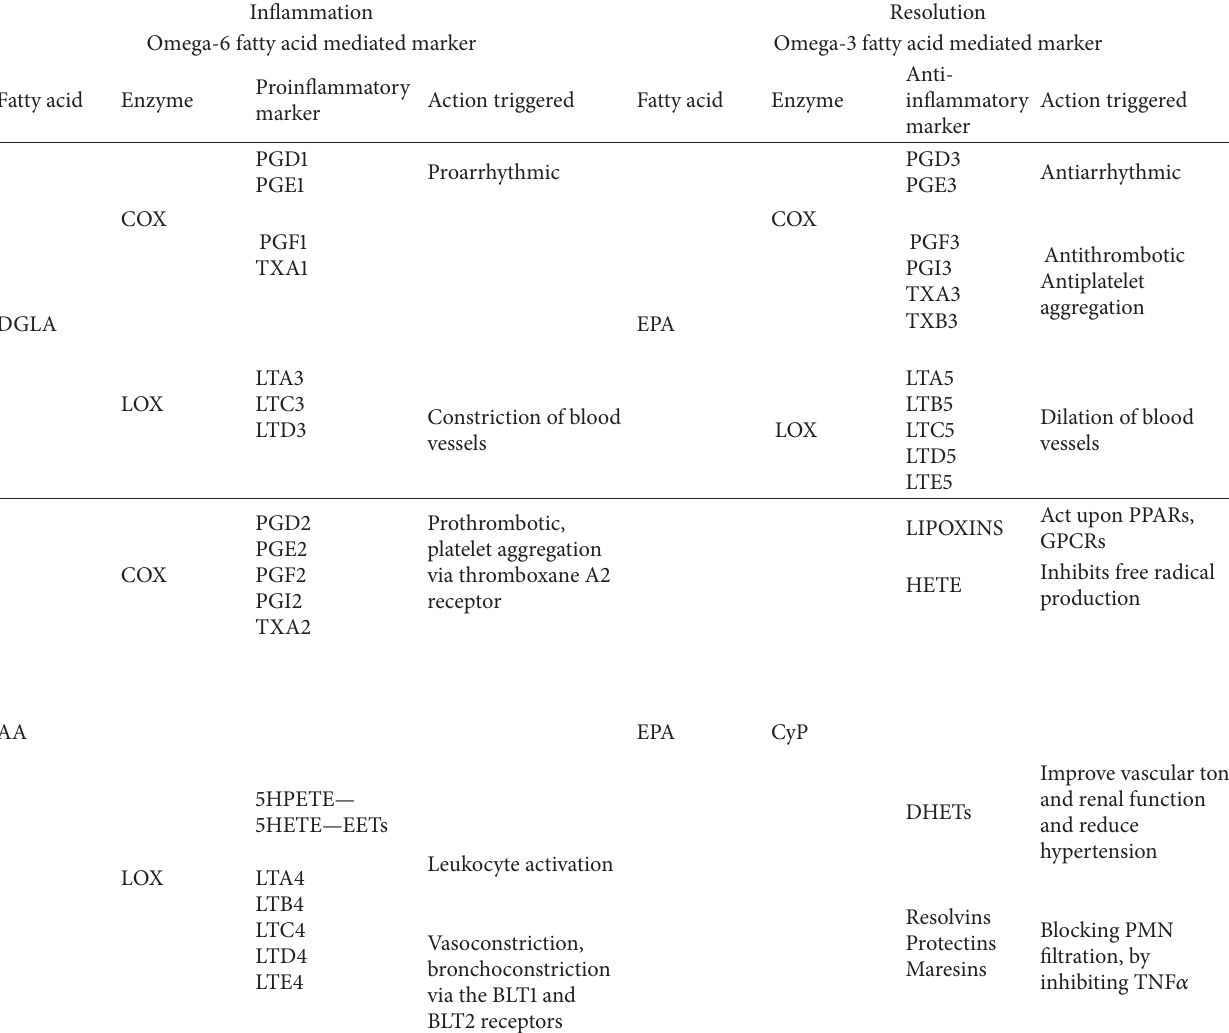
Table 1: Lipid signaling molecules and their actions in obesity related